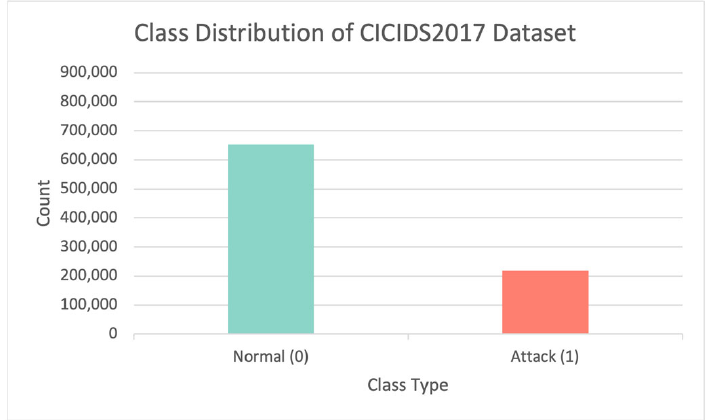
Figure 5. The class distribution in the CICIDS2017